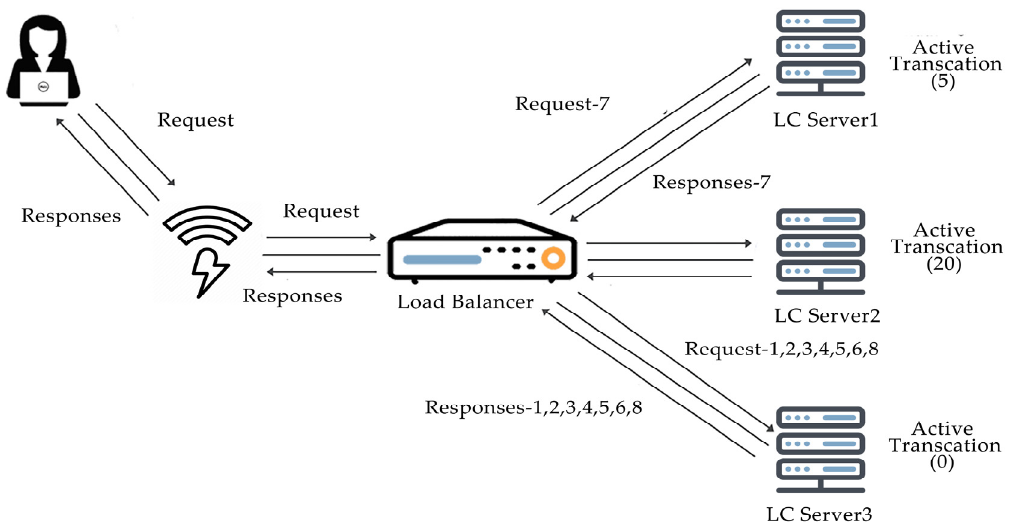
Figure 9. Model of the least connections algorithm.